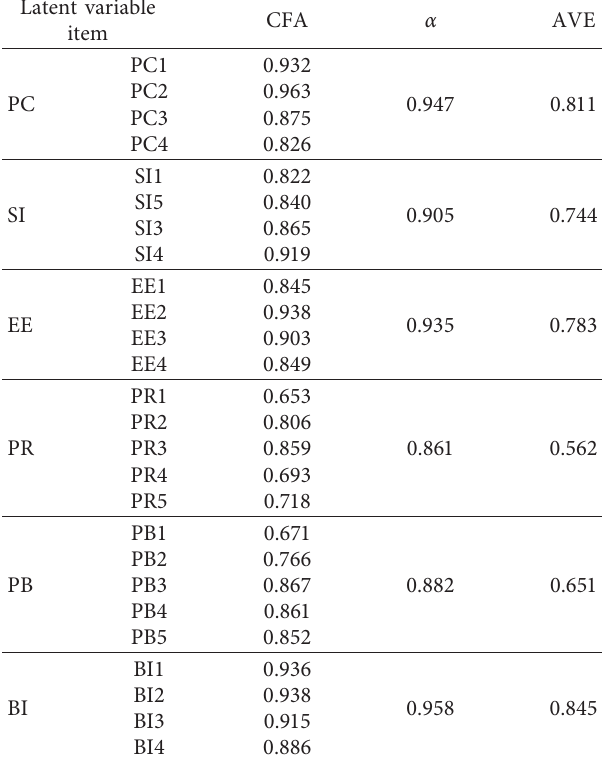
Table 4: Reliability and validity test results. Latent